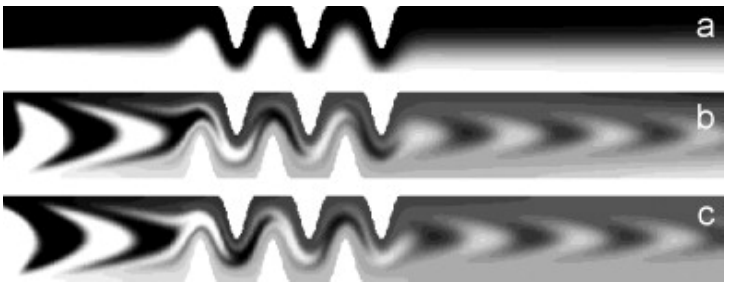
Figure 11. Distribution of species concentration in wavy-wall channels by (a) continuous injection, (b) pulsed injection with a certain period and (c) pulsed injection with the period double that for (b) (from Chen and Cho